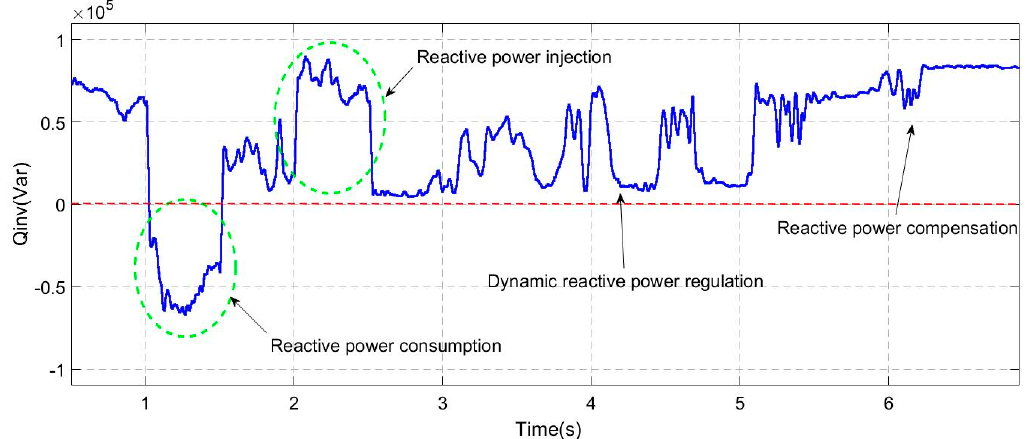
Figure 19. Waveform of reactive power in PV inverter under integrated control strategy. In 1 s–1.5 s, due to the rapid increase in sun irradiance and the less power consumption of the load, and the emergence of reverse power is observed.